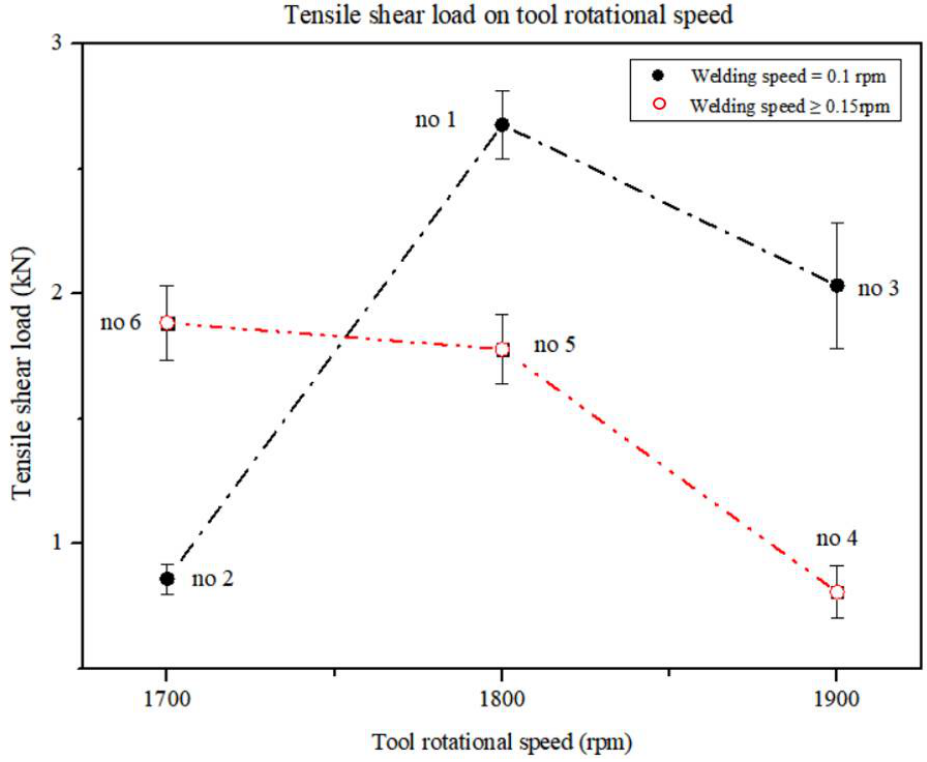
Figure 9. Comparison of TSL with TRS for experiment groups A and B [16].